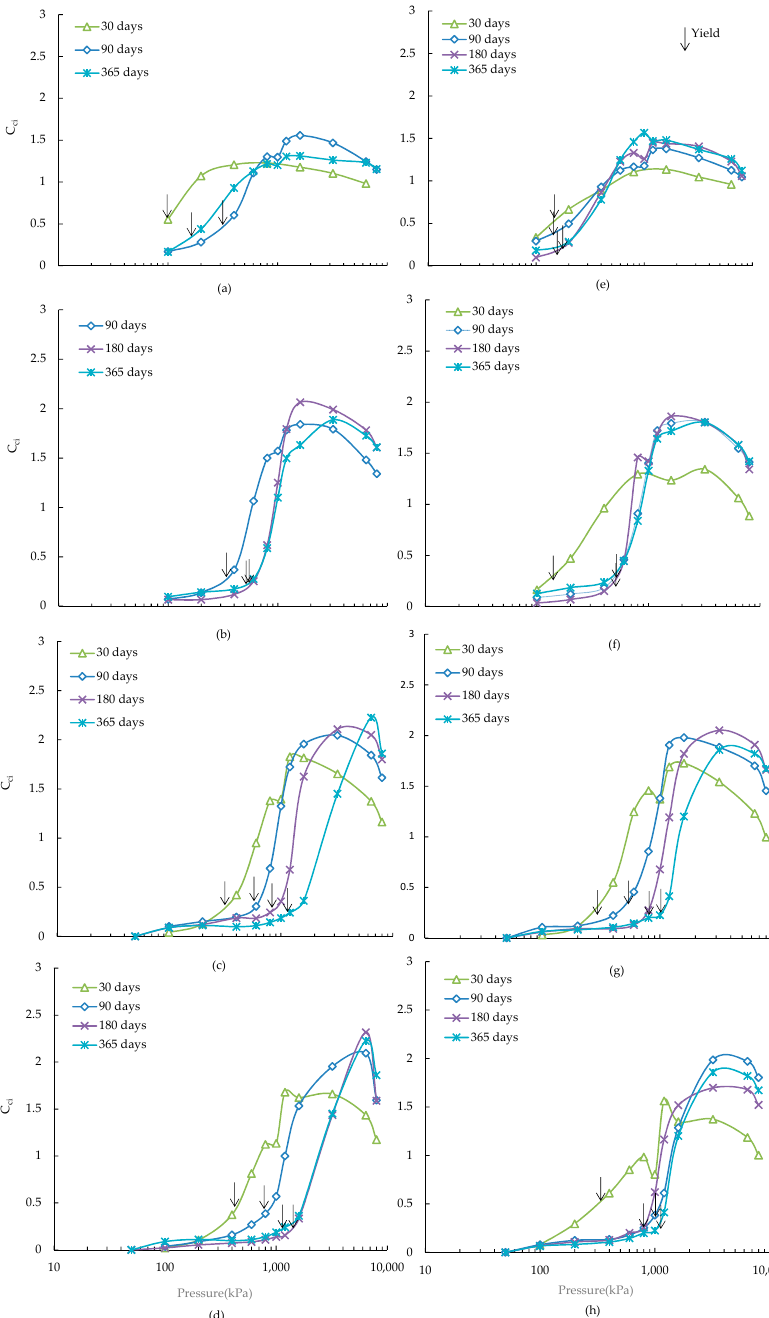
Figure 3. Variations of C ci with pressure for ASS treated with alkali activated ( a ) 5% slag; ( b ) 10% slag; ( c ) 15% slag; ( d ) 20% slag and for ASS containing 4% additional pyrite treated with alkali activated ( e ) 5% slag; ( f ) 10% slag; ( g ) 15% slag; ( h ) 20% slag.